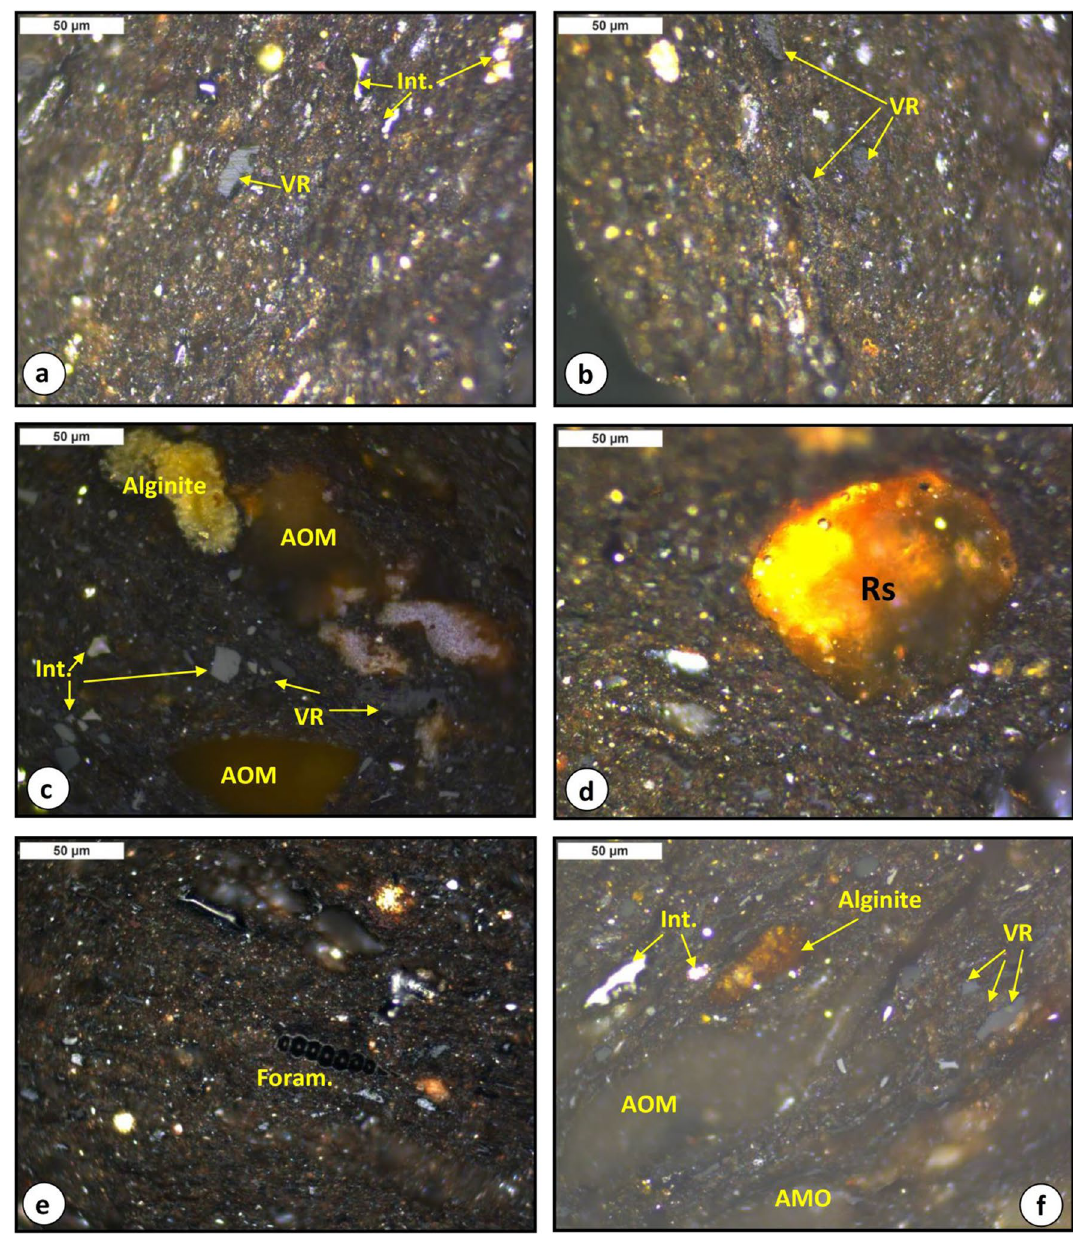
Figure 4. Photomicrographs of organic matter assemblage from the analyzed bituminous shales in the Paleocene Palana Formation; under reflected light, field width = 0.2 mm: ( a–d ) vitrinite (VR) and inertinite (Int.) organic matter associated with clay matrix, ( c ) mixed of organic matter, including alginite ( Botryococcus ), amorphous organic matter (AOM), vitrinite (VR) and inertinite (Int.) organic matter, ( d ) other liptinitic organic matter (resinite (Rs)), ( e ) planktonic foraminifera associated with organic matter and clay matrix, and ( f ) mixed of organic matter, including alginite ( Botryococcus ), AOM, vitrinite (VR) and inertinite (Int.) organic